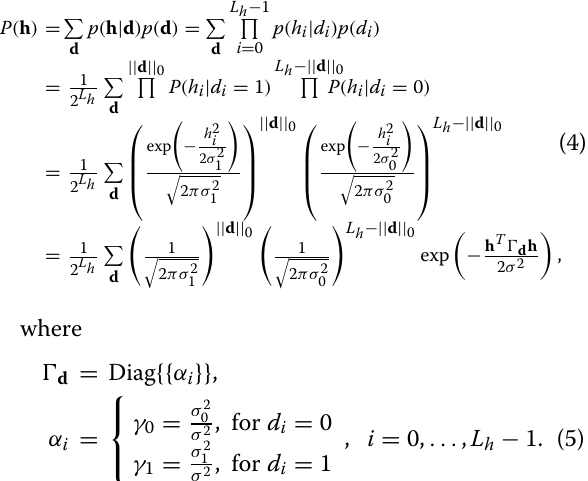
Fig. 1 System model for sparse ISI channel with blind sequential detector. The data b k is passed through an error control encoder with rate R = 1 The coded sequence x k is transmitted over a sparse ISI channel with additive white Gaussian noise w k . The received sequence y k is processed by a blind sequential detector and decoder to detect the transmitted data